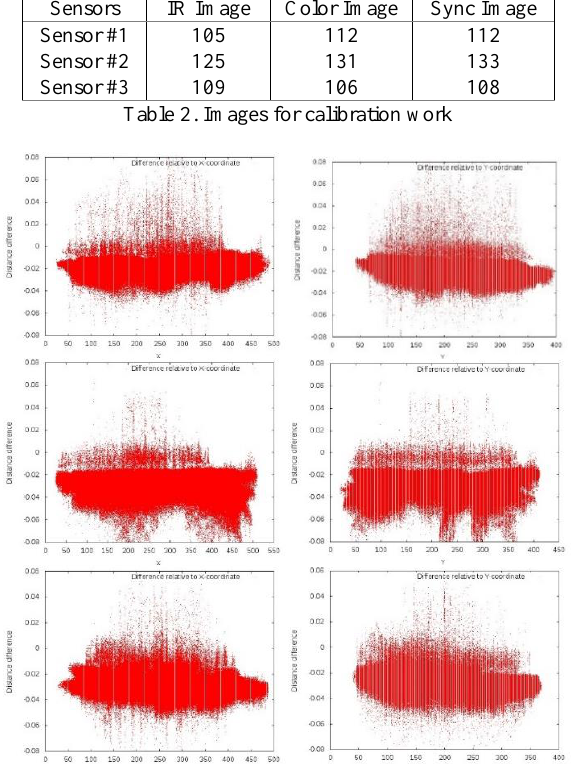
(a) Overview of indoor control field